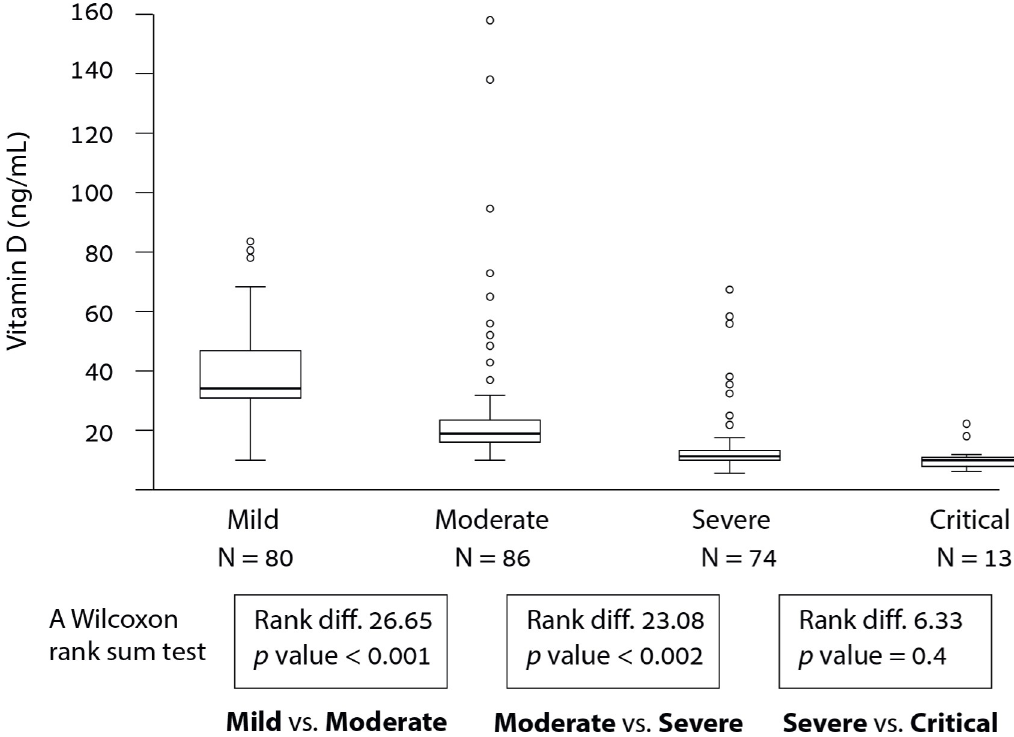
Fig 2. Box-and-whisker plots of the most recent pre-infection serum 25(OH)D levels before hospitalization were collected as a baseline (N = 253). The mean vitamin level was compared between the four categories of COVID-19 disease severity as determined by the WHO definition (WHO/2019-nCoV/clinical/2020.5). A Kruskal-Wallis test for multiple-category comparison shows a significant difference between groups p < 0.001. A Mann-Whitney test compared vitamin D mean rank of two neighboring categories sequentially; mild compared with moderate (mean difference, 12.96 ng/mL; [Rank difference 26.65] p < 0.001); moderate compared with severe (mean difference, 10.72 ng/mL [Rank difference 23.08]; p < 0.002); Severe compared with Critical (mean difference, 3.96 ng/mL [Rank difference 6.33]; p = 0.40). The boxes present the range of vitamin D values within the interquartile range (50% of the cases). The whiskers outside the box mark the most upper and lower values within 1.5 times the interquartile range. Outliers’ values in each group are represented with empty